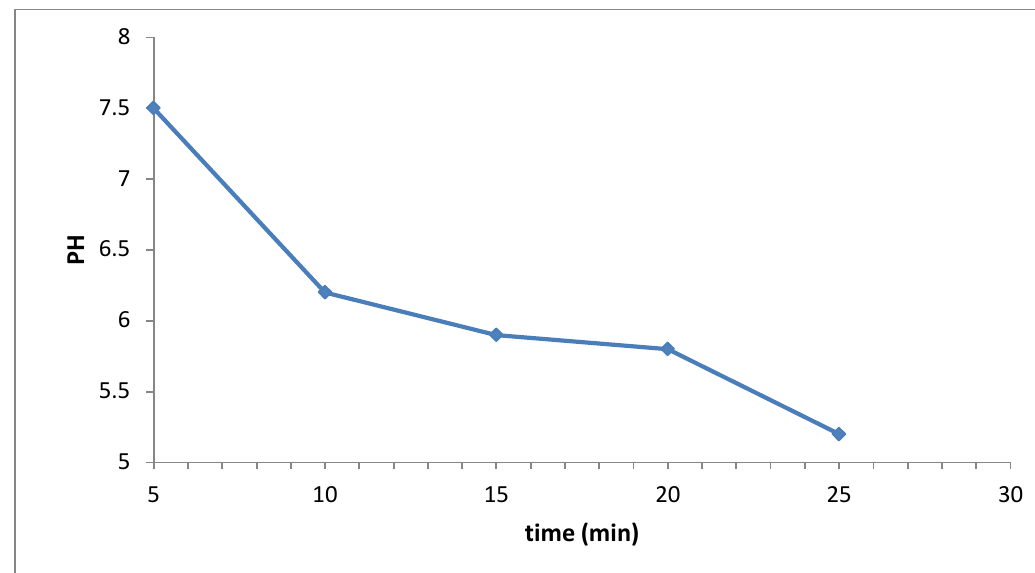
Figure 6: The change in pH value as a function of time.